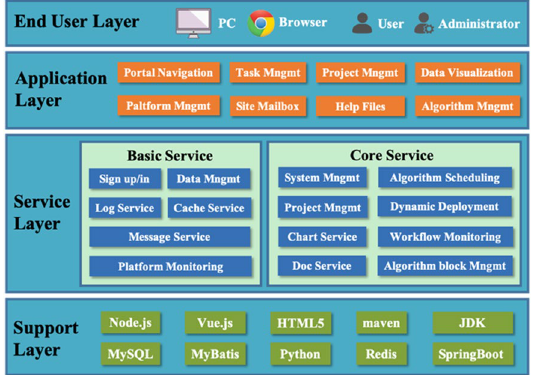
Figure 3 Software architecture of